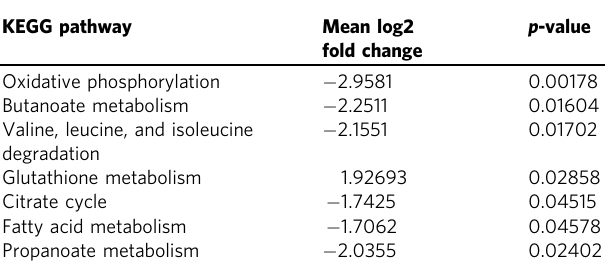
Table 1 Top KEGG metabolic pathways signi fi cantly differing with IL-1 β